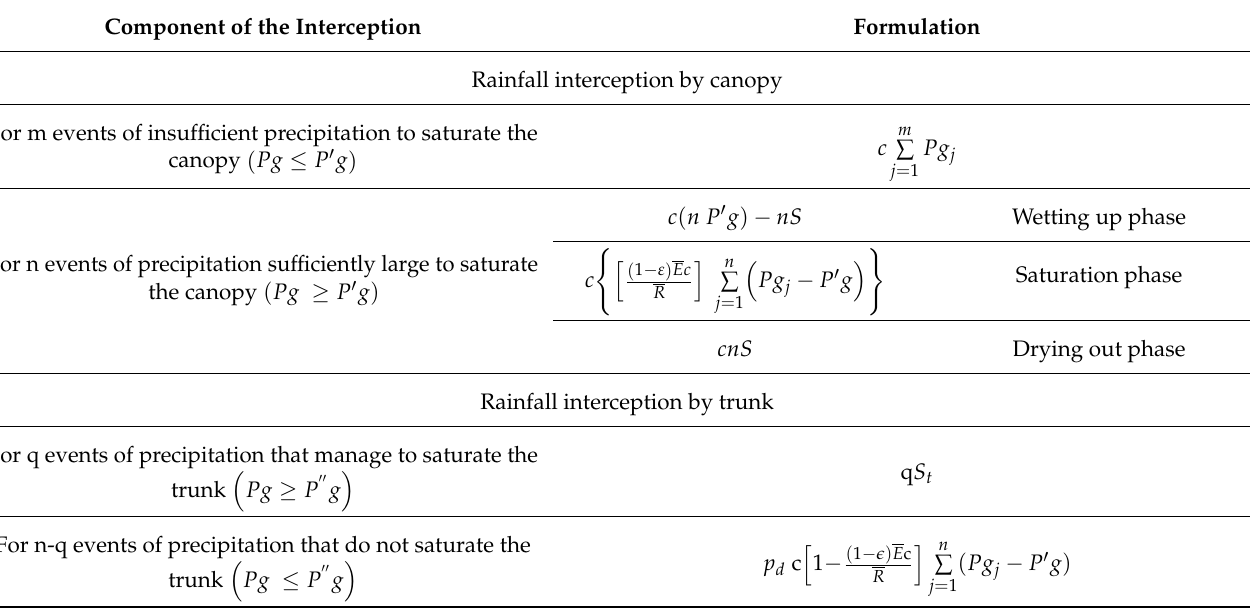
Table 2. Components of rainfall interception for the sparse Gash analytical model. Component of the Interception Formulation Rainfall interception by